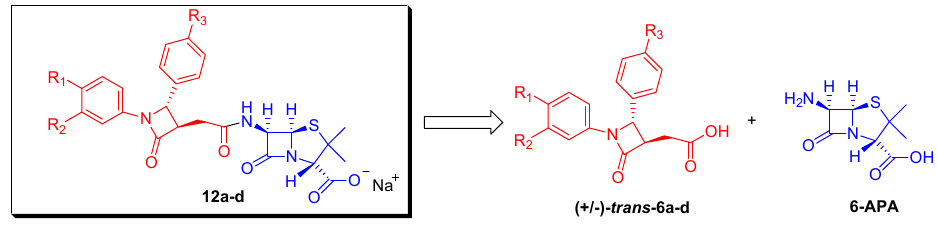
Scheme 1. General retrosynthetic strategy.